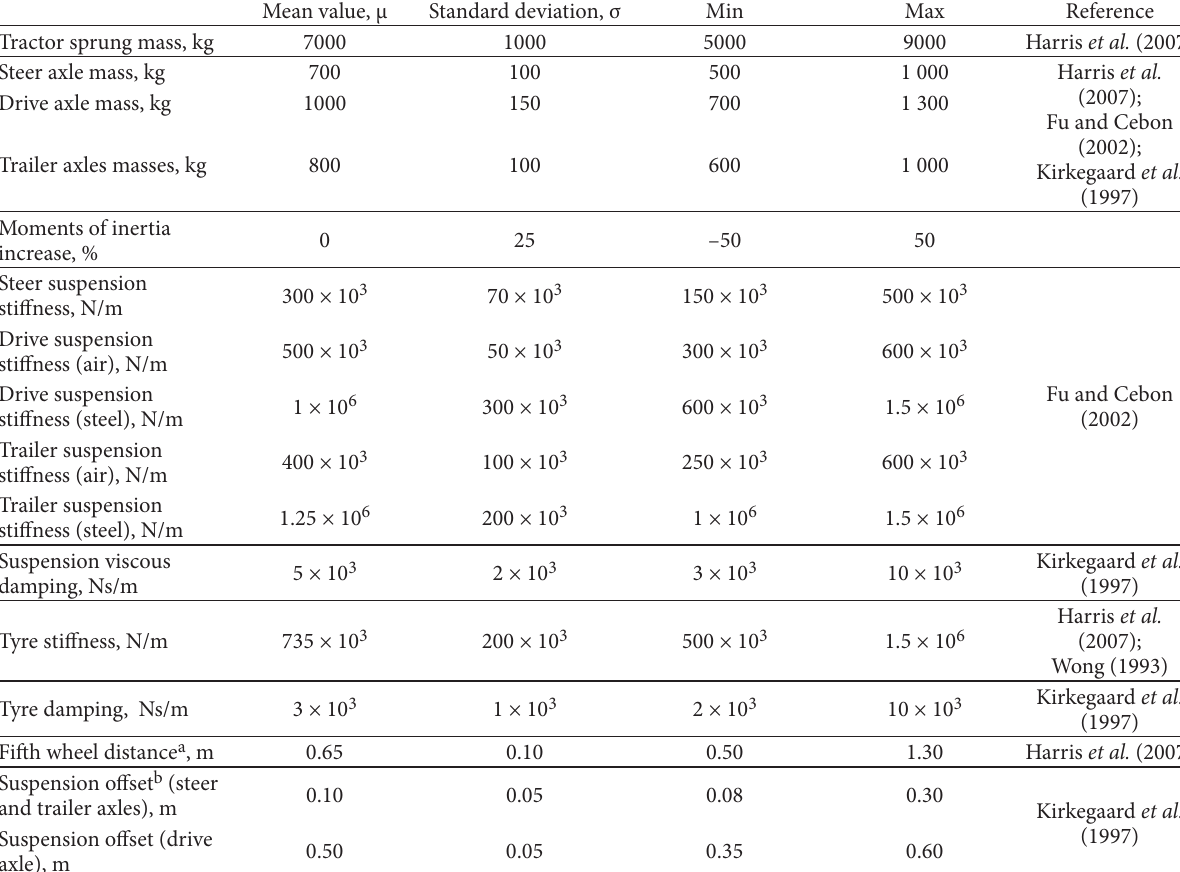
Table 2. 5-axle trucks parameters and variability